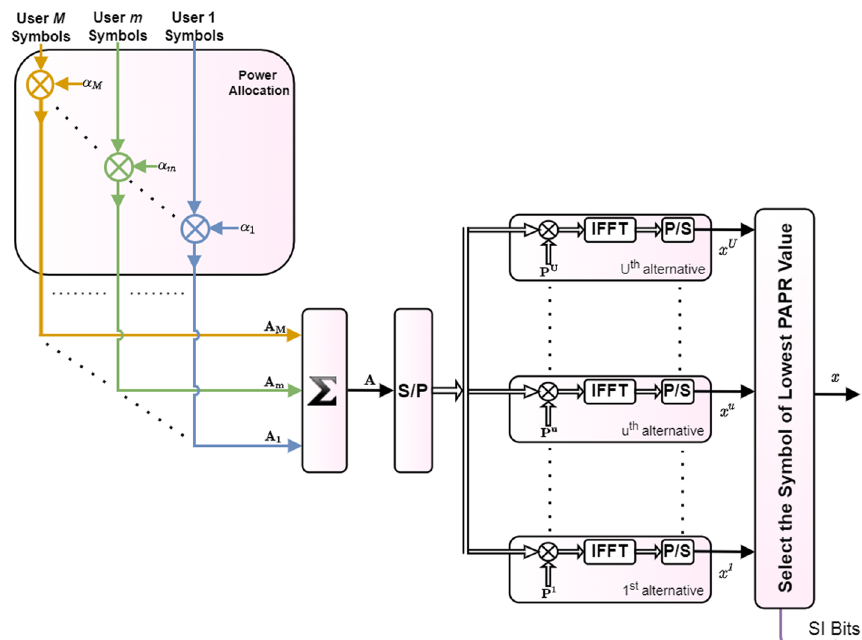
Fig. 3 Block diagram of the conventional SLM technique for DL OFDM-NOMA